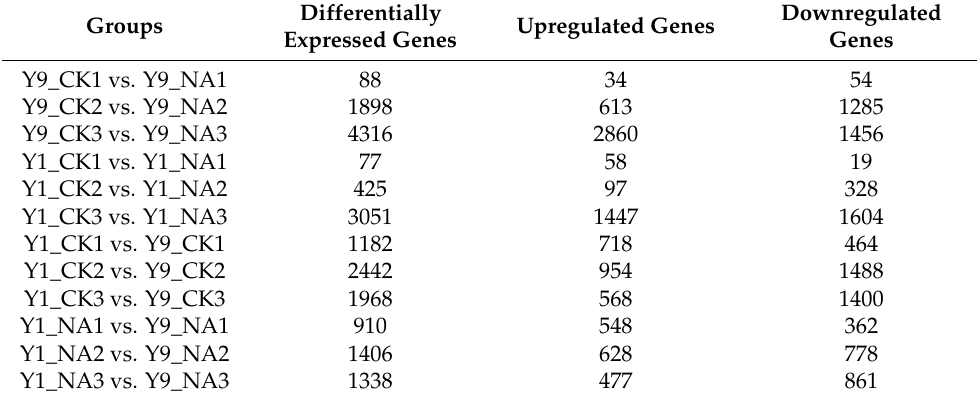
Table 4. Statistics of differentially expressed